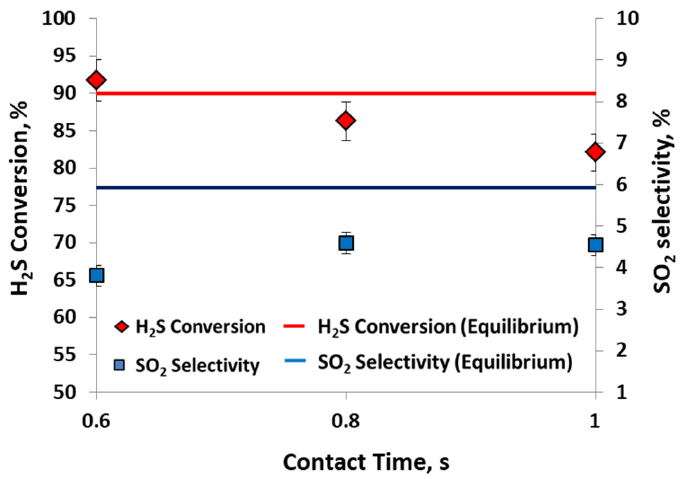
Figure 5. Effect of the contact time over 20 V-CeO 2 catalyst on the H 2 S conversion and SO 2 selectivity (T = 327 °C, H 2 S = 10 vol%).